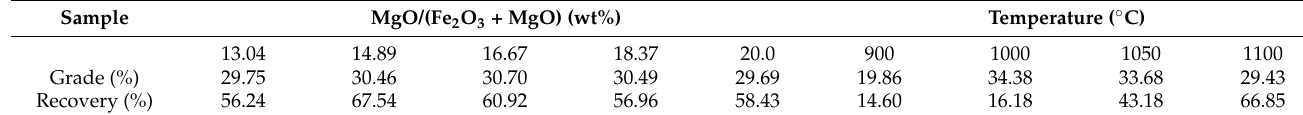
Table 5. The grade and recovery of the de-alkalized red mud at 50 mT.